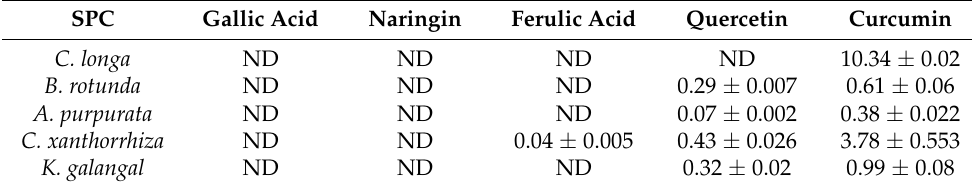
Table 4. SPC content (mg/g) measured by HPLC-PAD.